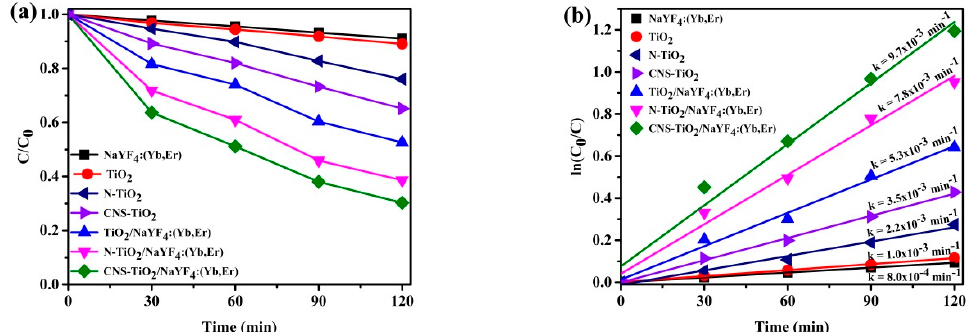
Figure 8. ( a ) MB peak absorbance against the visible light activation time and ( b ) correlated rate of kinetics.